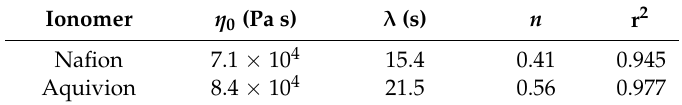
Table 2. Parameter variables of modified-Carreau model (Equation (1)) for two precursor